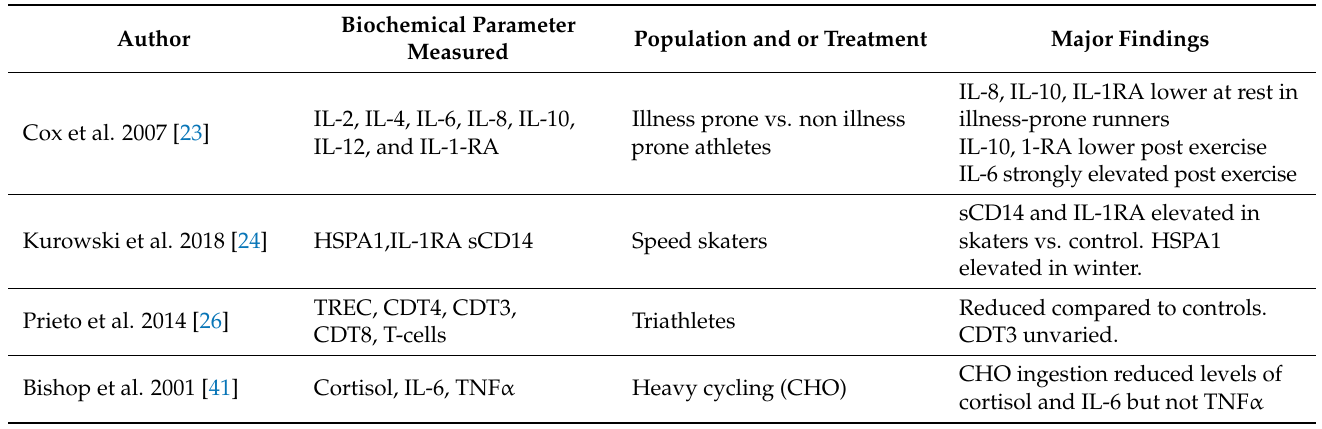
Table 1. Biochemical/biological parameters measured in literature in heavy trained athletes (CHO: carbohydrates ingestion).